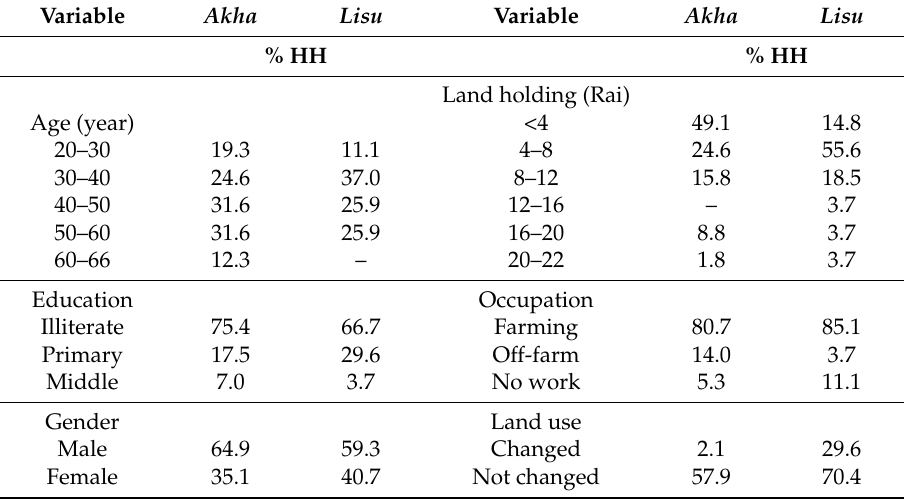
Table 2. Characteristics of respondents who perceived climate change. Variable Akha Lisu Variable